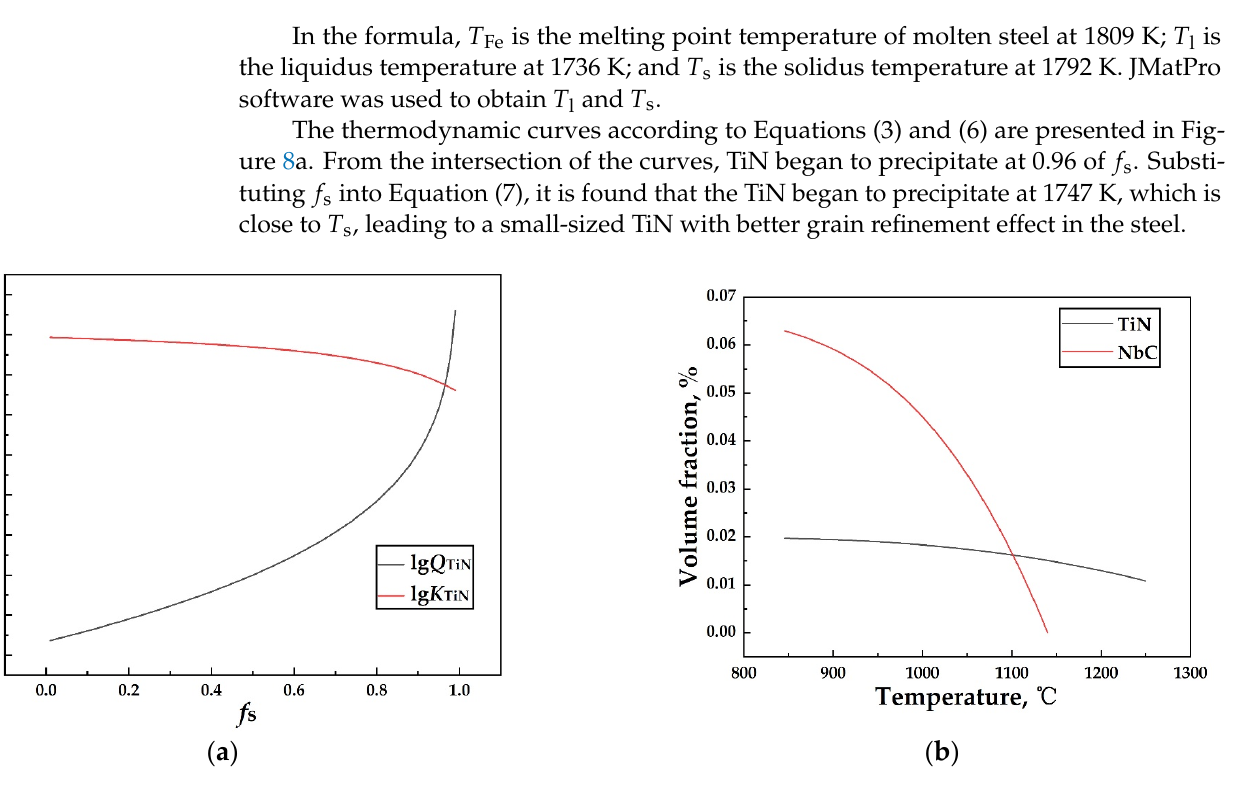
Figure 8. Thermodynamic analysis of TiN and NbC: ( a ) Relationship between k TiN and Q TiN of TiN inclusion and f s , ( b ) variation of volume fraction ( f ) of NbC and TiN with temperature. The reaction formula and theoretical concentration product (( K NbC ) r , ( K TiN ) r ) of the NbC and TiN in austenite are shown in Equations (8), (9) and (11), and the stochiometric ratio of NbC and TiN is shown in Equations (10) and